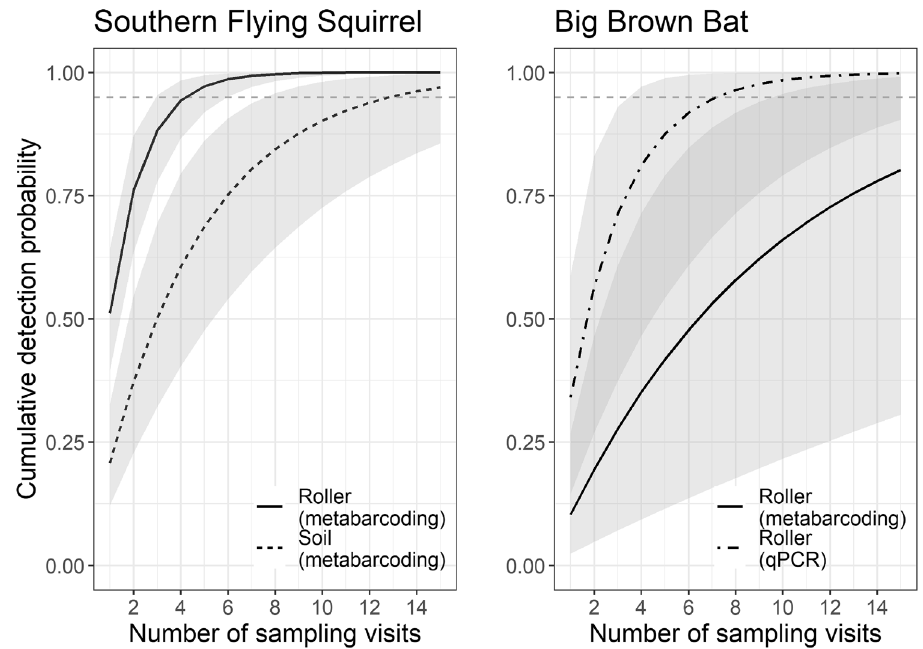
Figure 5. The cumulative probability of detecting a southern flying squirrel (left plot) or big brown bat (right plot) at least once at an occupied tree given increasing numbers of sampling visits. The plot, for southern flying squirrel, a cryptic arboreal species, illustrates the differences between tree bark surface (‘roller’) versus soil eDNA collection methods within a metabarcoding detection framework. The plot for big brown bat illustrates the difference between qPCR and metabarcoding molecular detection methods on samples collected using roller eDNA techniques. Shaded areas show 95% credible intervals. The gray dashed horizontal line represents a cumulative 95% certainty of detecting the species at least